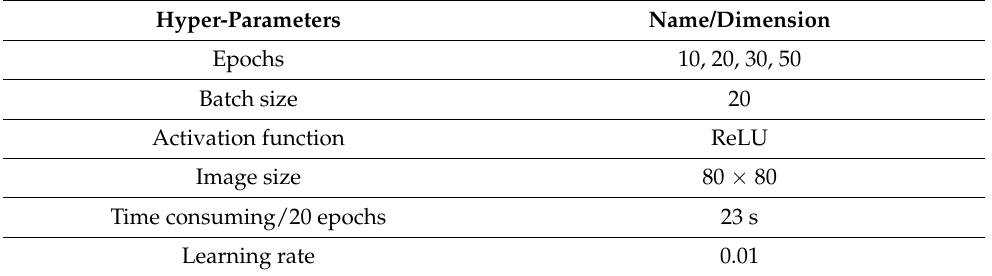
Table 3. The hyper-parameters of the CNN